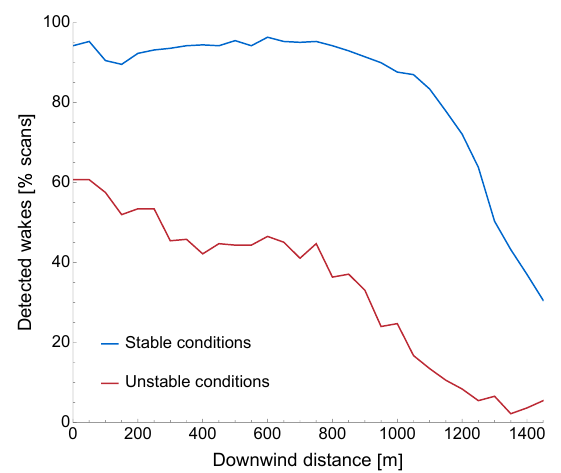
Figure 6. Percentage of wakes detected by the characterization al- gorithm vs. downwind distance, for stable and unstable conditions of the atmosphere (neutral conditions were detected only for very short periods and are not included here). Results from PPI scans performed on 23 and 26 August